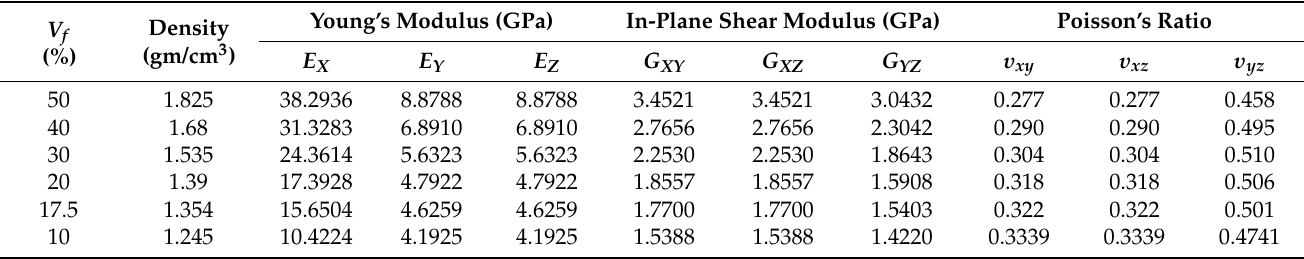
Table 4. Lamina’s elastic constants for different V f %